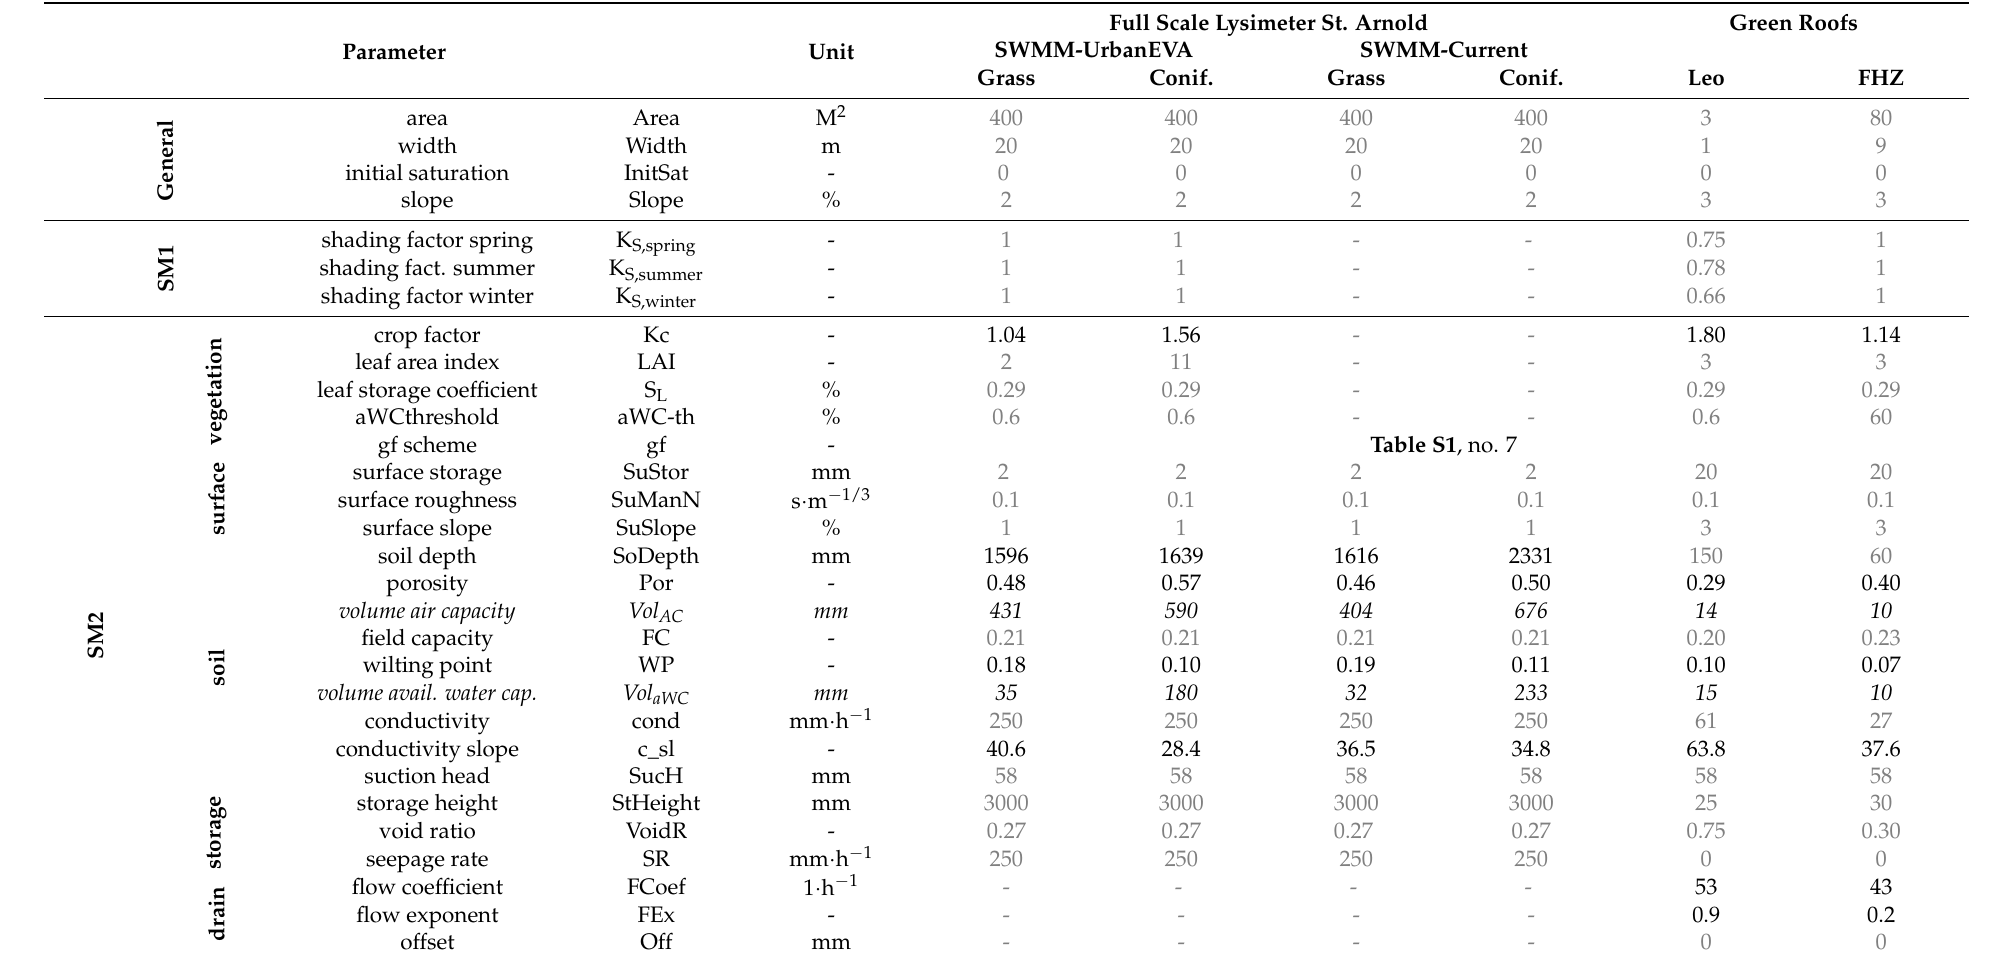
Table 7. LID parameters obtained from model calibration. (grey = fixed parameter, black = varied parameter).